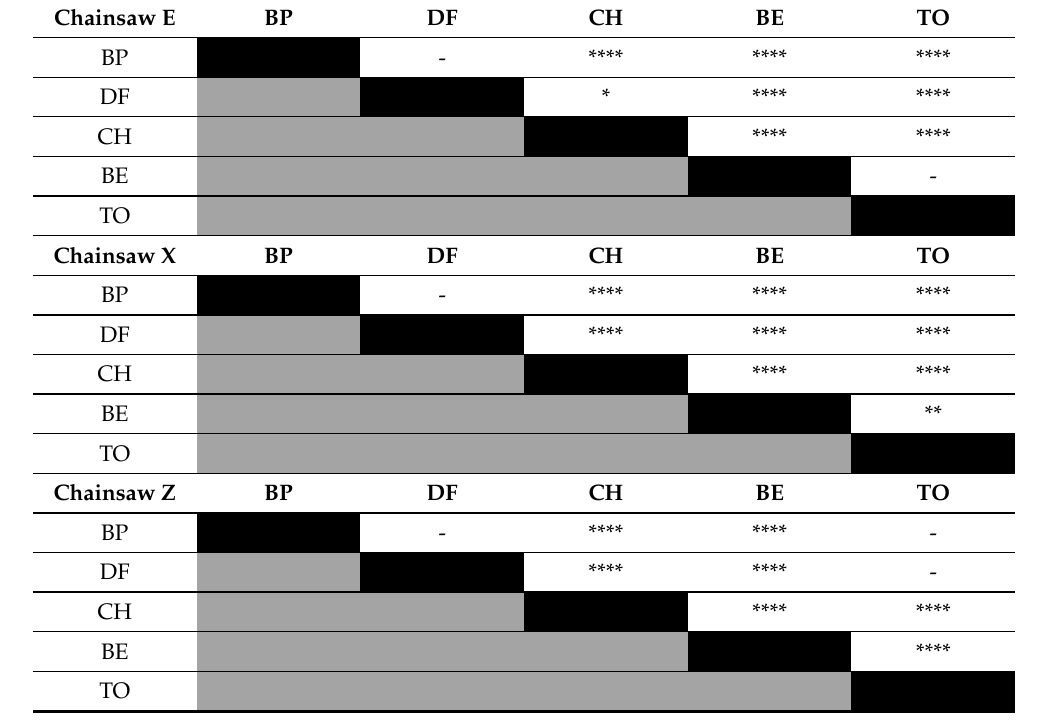
Table 5. Comparison of cutting times with and without wood defects using Dunn test, and